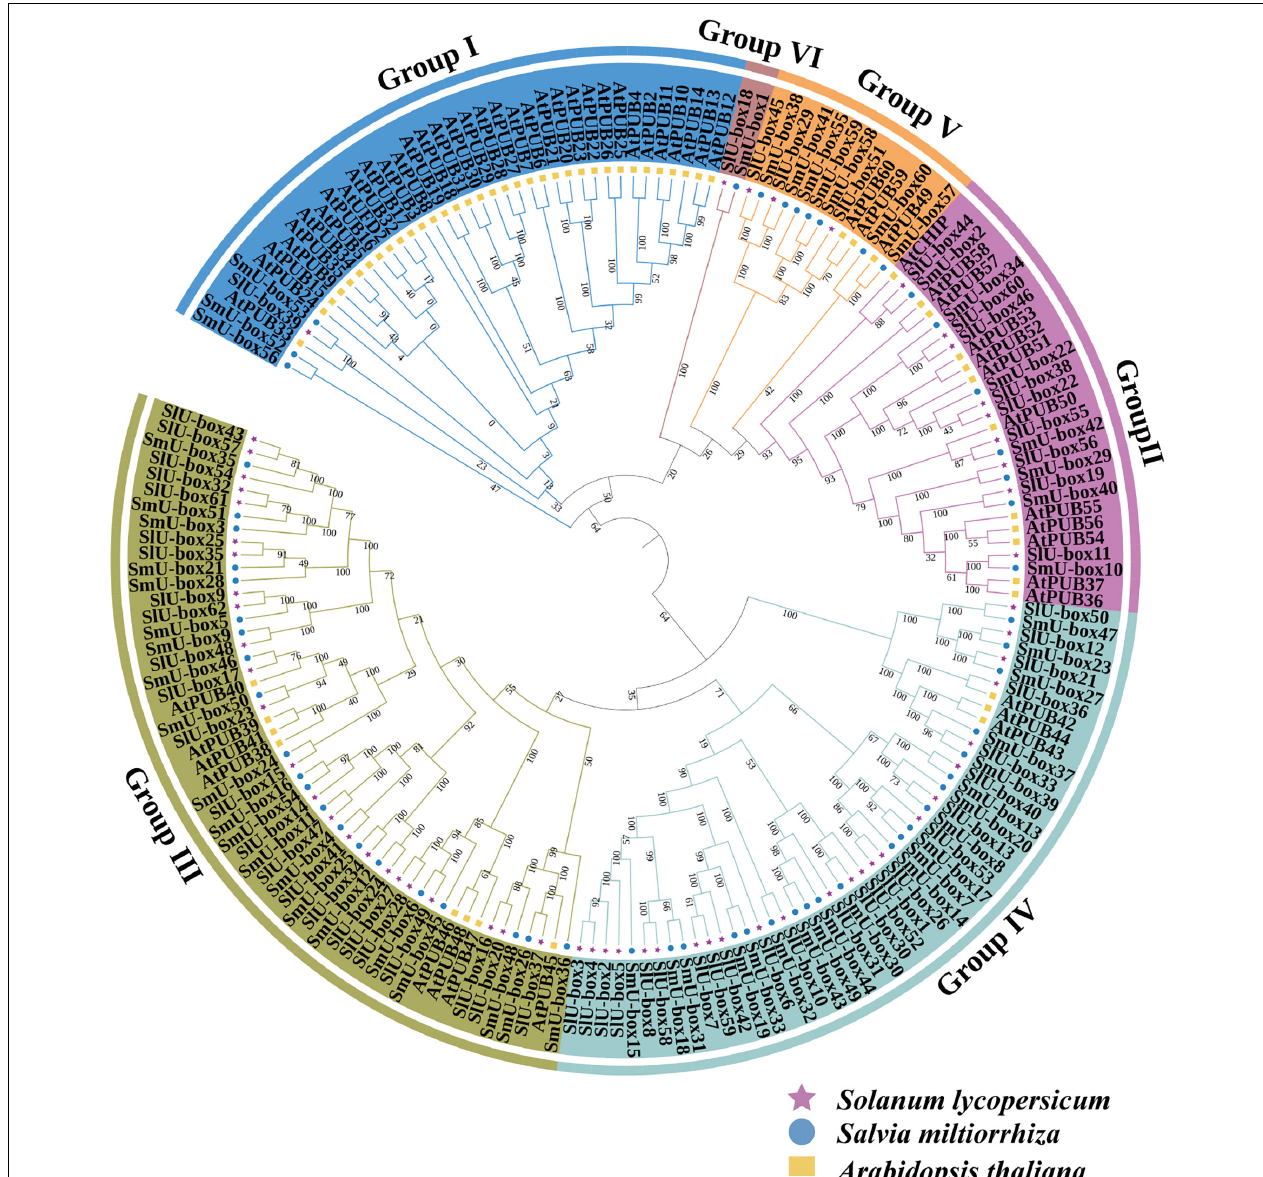
FIGURE 1 | Phylogenetic tree of S. miltiorrhiza U-box E3 ubiquitin ligase genes. The phylogenetic tree was constructed by the neighbor-joining method with 1,000 bootstraps. The numbers on the nodes indicate the bootstrap values after 1,000 replicates. S. miltiorrhiza U-box gene family was clustered into six subgroups and named Group I-VI. The purple star, yellow square, and blue round represented the U-box proteins in Solanum lycopersicum , Arabidopsis thaliana , and S. miltiorrhiza ,